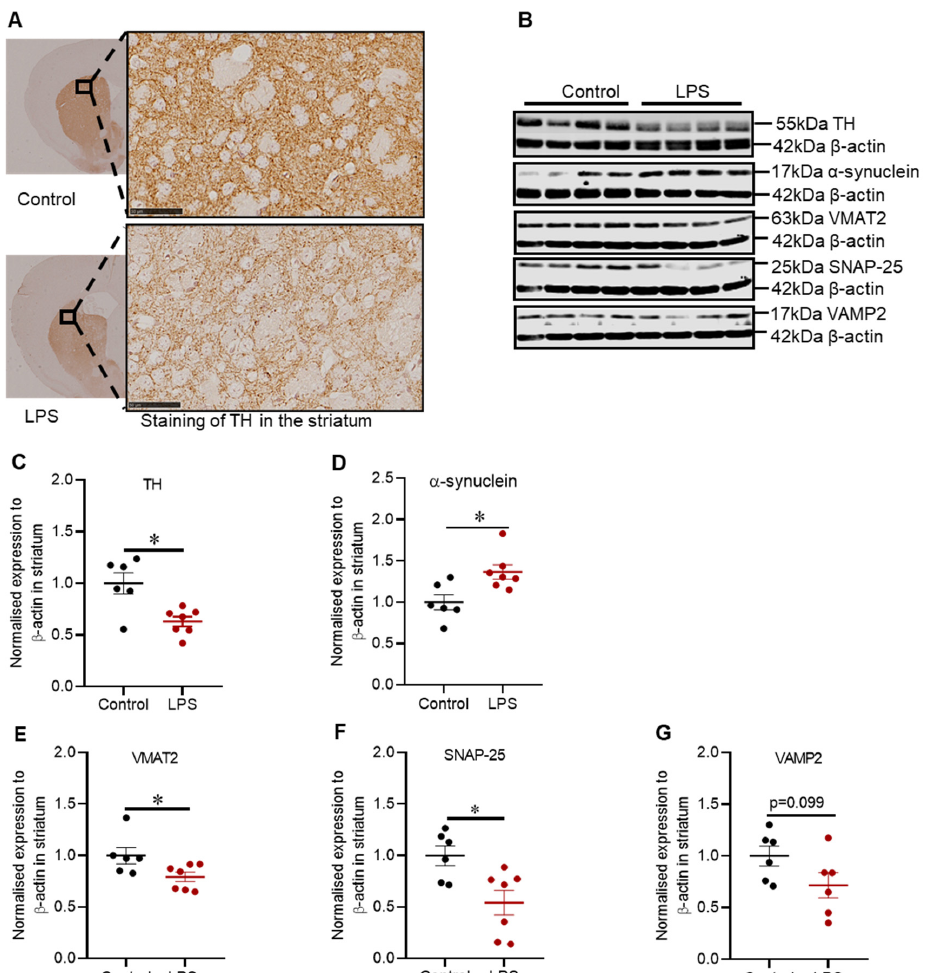
Figure 2. Administration of LPS altered the expression of TH, α -synuclein and synaptic proteins in the striatum of C57BL/6 mice. ( A ) Representative images for immunohistochemical detection of TH in the striatum. ( B ) Representative immunoblots for TH, α -synuclein, VMAT2, SNAP-25 and VAMP2 proteins in the striatum. ( C ) Densitometric analysis of TH protein. ( D ) Densitometric analysis of α -synuclein protein. ( E ) Densitometric analysis of VMAT2 protein. ( F ) Densitometric analysis of SNAP-25 protein. ( G ) Densitometric analysis of VAMP2 protein. The results are presented as mean ± SEM (control n = 6; LPS n = 6–7). Statistical analysis was performed with a Mann–Whitney test, p < 0.05 (*). Immunohistochemical detection of TH (scale bar: 50 µm; microscopic magnification: X400) (control n = 5; LPS n = 5).